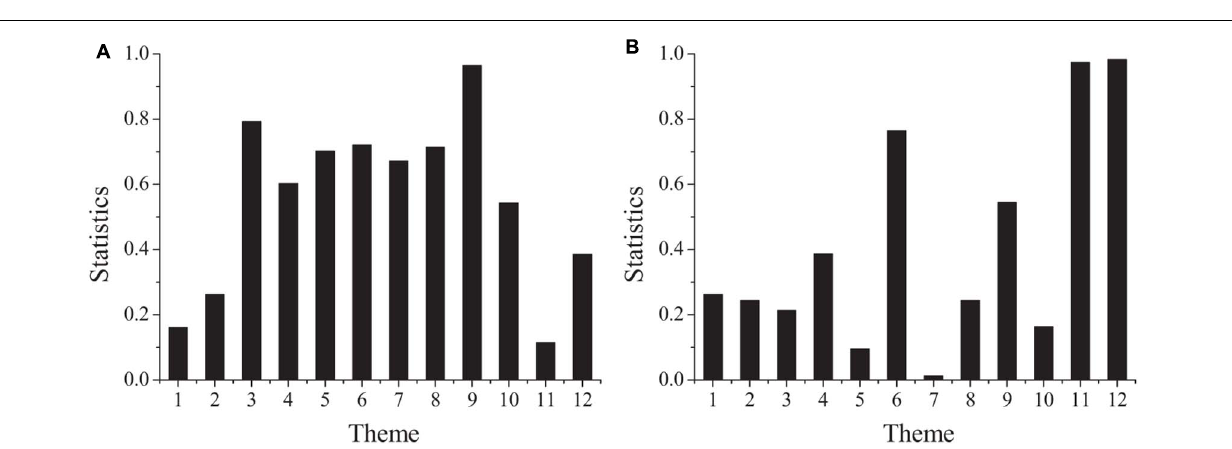
FIGURE 2 | The differences of psychological contract in different genders ( A: the second part; B: the third